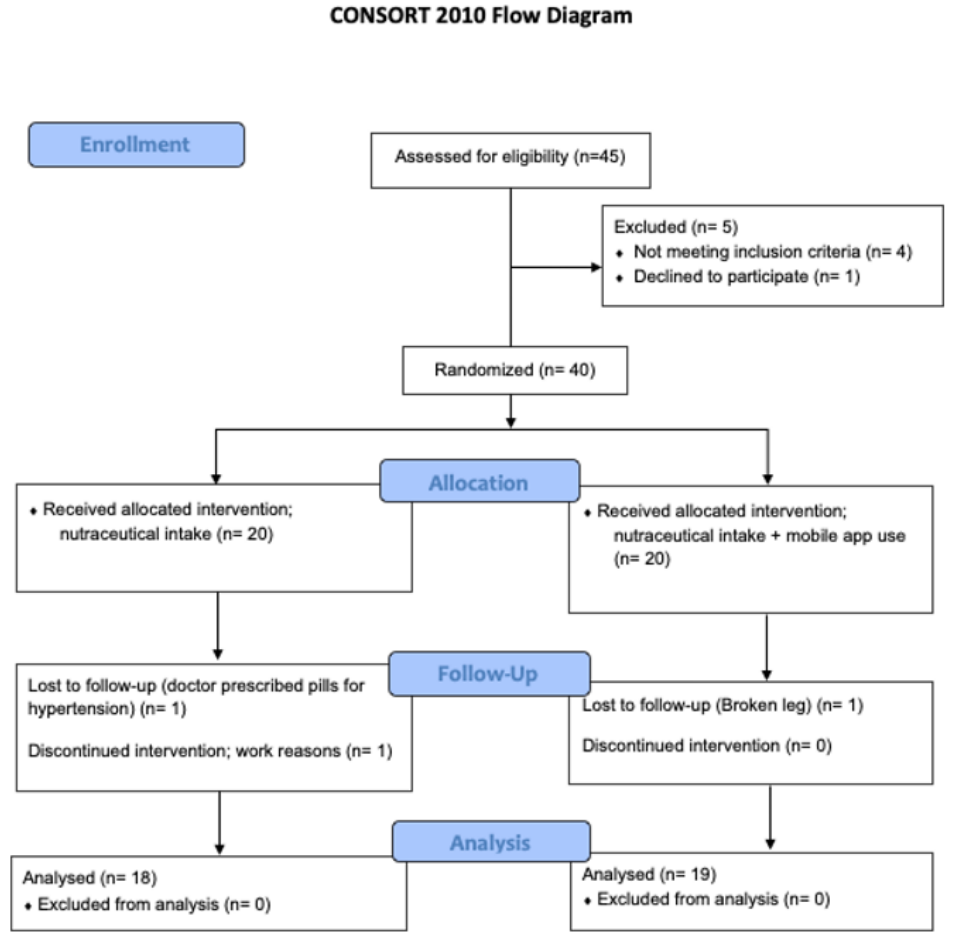
Figure 2. Consort 2010 Flow